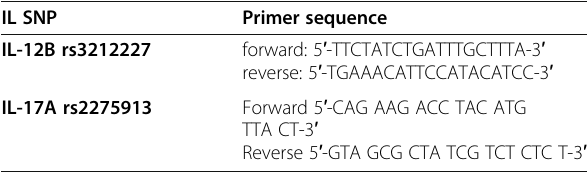
Table 1 IL-12B and IL-17A primers sequence IL SNP Primer